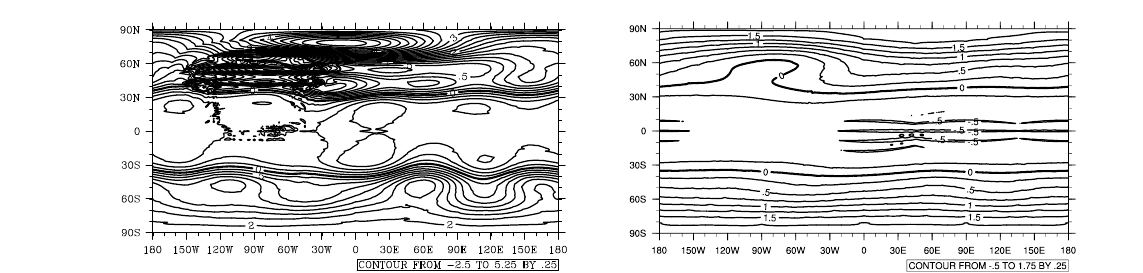
(a) Error plot for the uniform grid. The resolution is  x unit = 3  . The error varies from